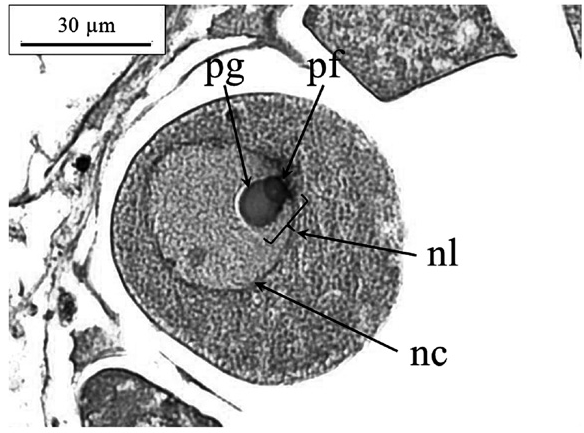
Fig. 4. – Histological section of the gonads of a hermaphrodite indi- vidual. Arrows point to mature oocytes; broken arrows point to the mass of sperm. Scale bar is 100 µm.